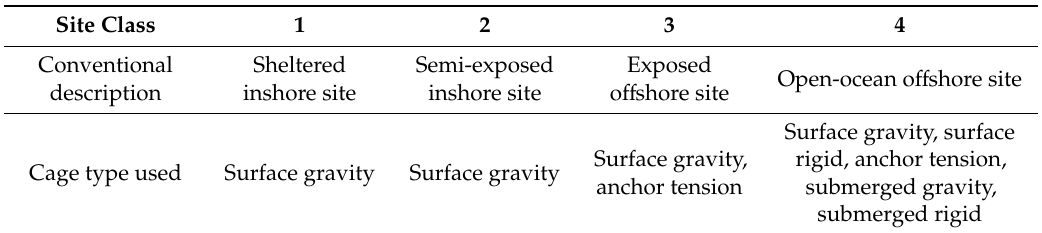
Table 2. Marine cage site classification [11].